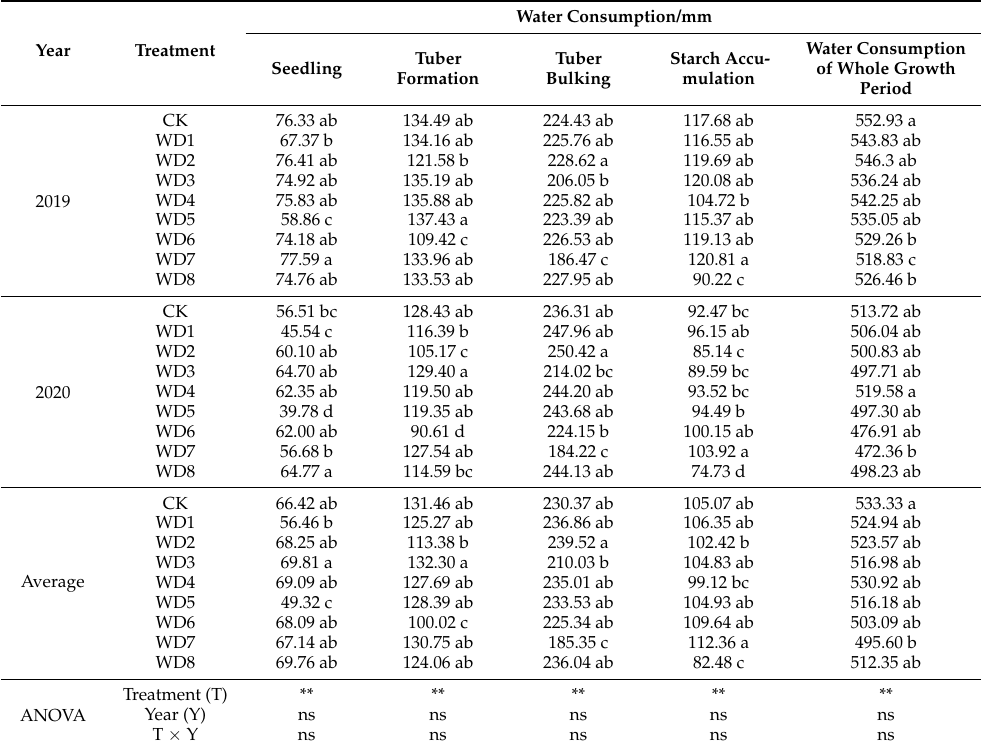
Table 2. Water consumption of potato at different growth